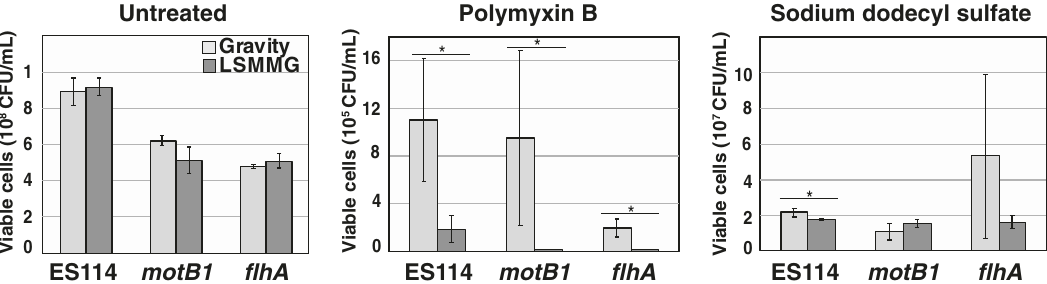
Fig. 6 Direct cell plating counts for Vibrio fi scheri exposed to polymyxin B and sodium dodecyl sulfate. Viable cell counts of wild-type Vibrio fi scheri and motility mutants ( motB1 and fl hA ) in the presence of cell membrane-disruption agents polymyxin B and sodium dodecyl sulfate grown under gravity (light gray) and low-shear modeled microgravity (LSMMG, dark gray) conditions. Error bars indicate the standard error of the mean. Asterisks indicate signi fi cant differences between the data sets ( p < 0.05; Welch ’ s t -test).